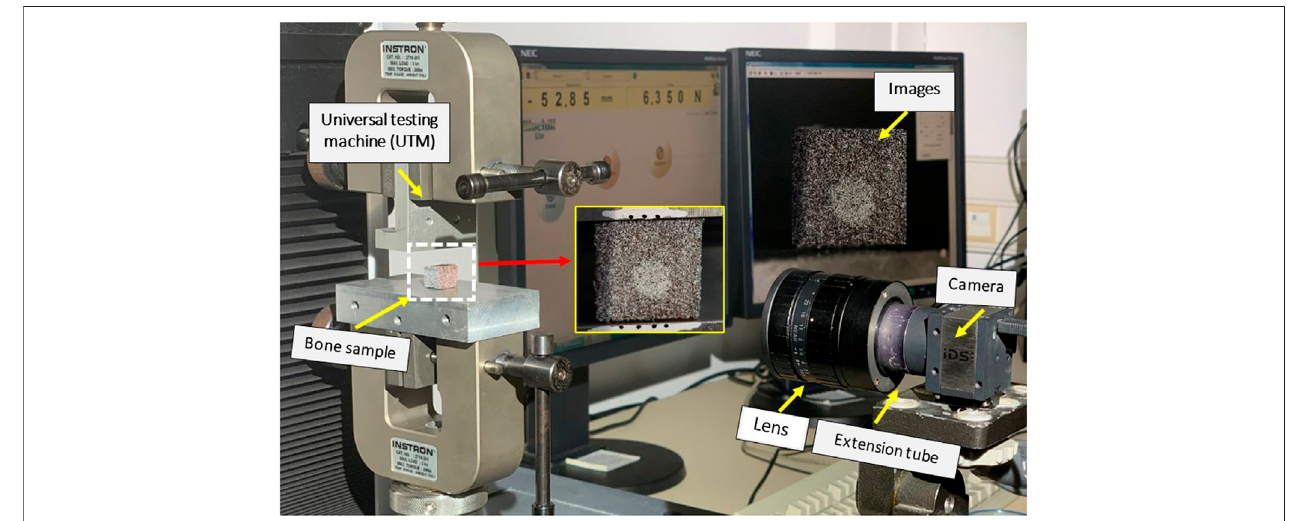
FIGURE 1 | Uniaxial compression test with speckle pattern on bone sample and markers on the support.